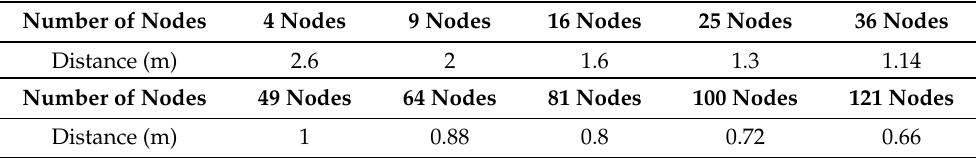
Figure 10. ( 1 ) Original data obtained from the 289 points measured within the crop, ( 2 ) data after the data smoothing filter and ( 3 ) Kriging map that served as the initial reference map. Points [1], [2] and [3] within the figure show the maximum and minimum points detected in some regions. Table 2. Distance between nodes for n × n , for n = 2, . . . ,11.